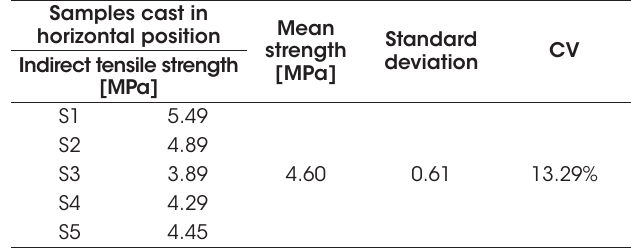
Indirect tensile strengths measured in reference conventional tests